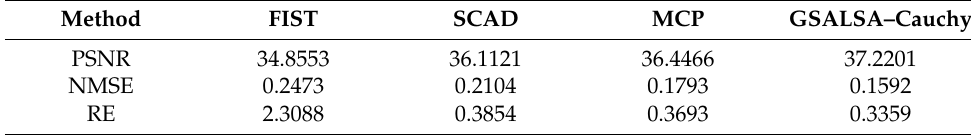
Table 6. PSNR, NMSE and RE of pistol model under 75%